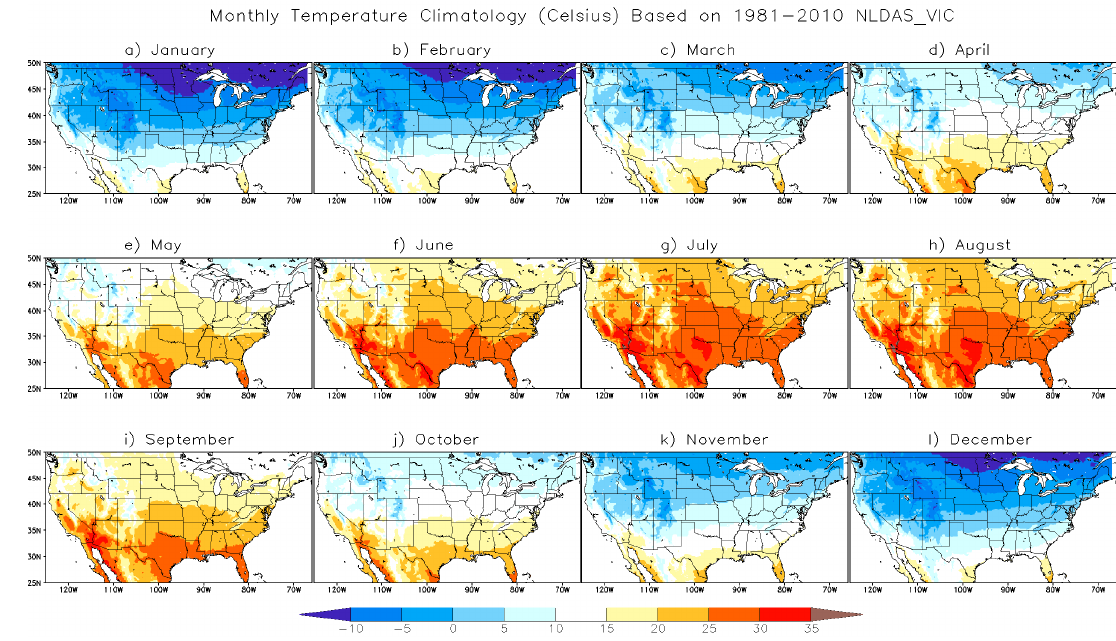
Figure 4. Monthly temperature climatology (°C) based on 1981–2010 NLDAS-2 data.